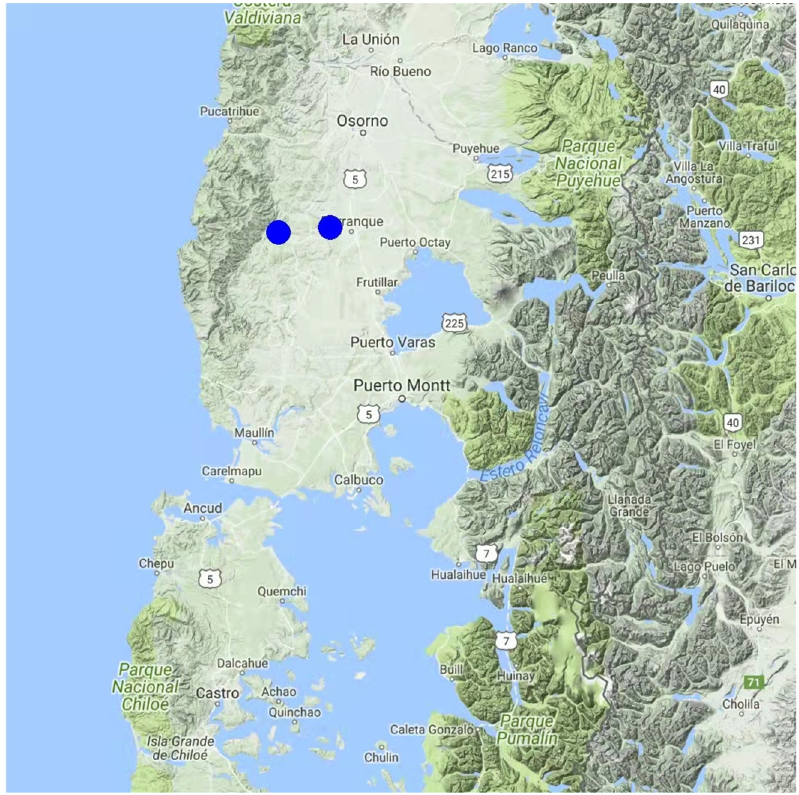
Figure 5. Map of the Los Lagos Region (Chile, 39 ◦ 16 (cid:48) S to 44 ◦ 04 (cid:48) S) indicating the two hive locations where beeswax samples tested positive for the pesticide